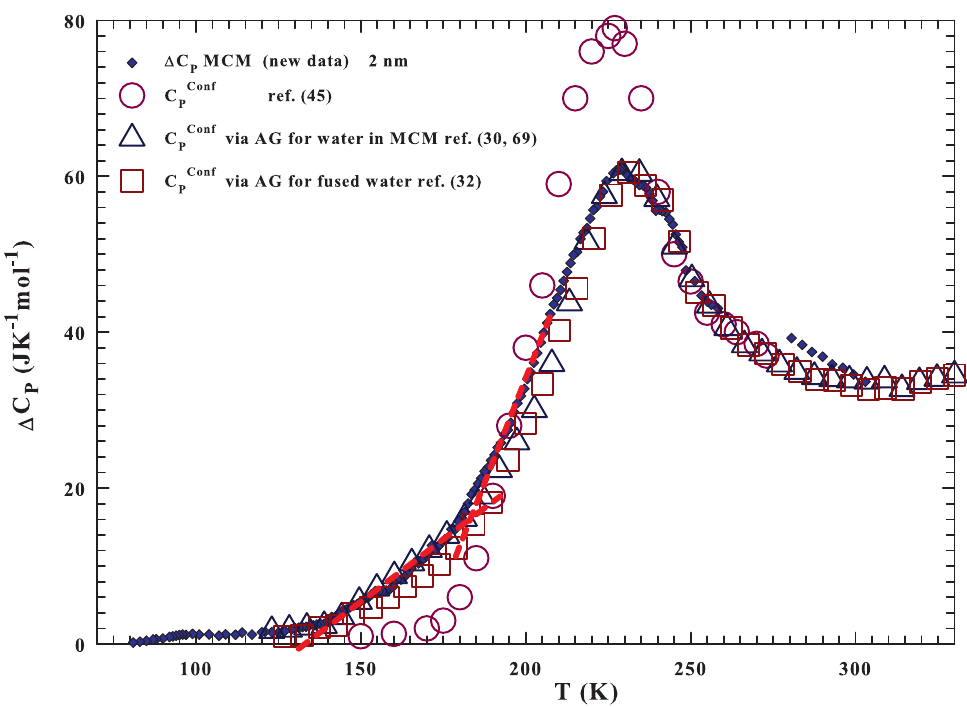
Figure 6. The configurational C Conf Conf / ∂ T P = T ( ∂ S ) P obtained from the transport data compared with those mearasured as ∆ C P in confined liquid and evaluated by using thermodynamical concepts [45].